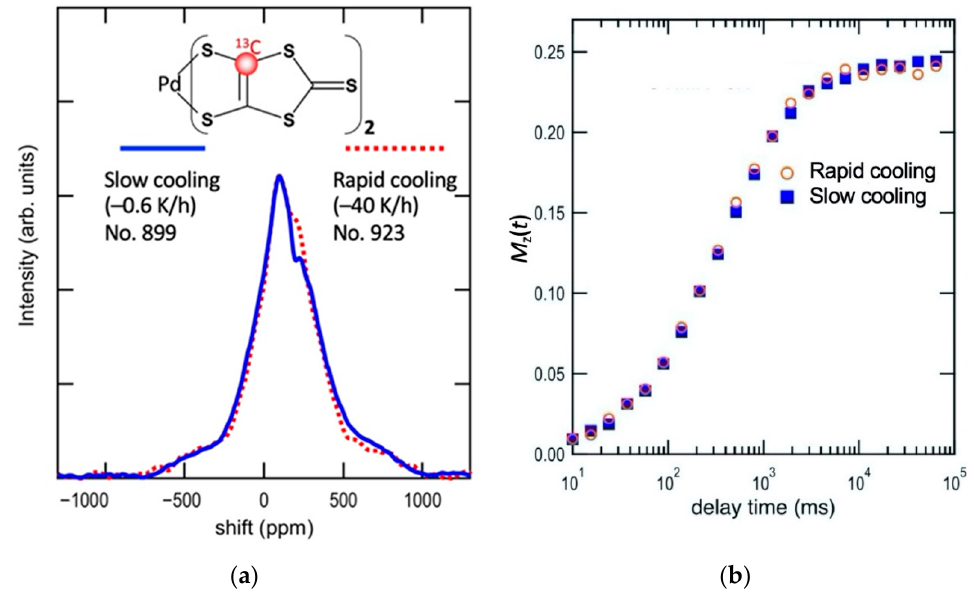
Figure 4. 13 C-NMR of β′ -EtMe 3 Sb[Pd(dmit) 2 ] 2 at 5 K with rapid and slow cooling rates. ( a ) Spectra; and ( b ) nuclear magnetization curves.